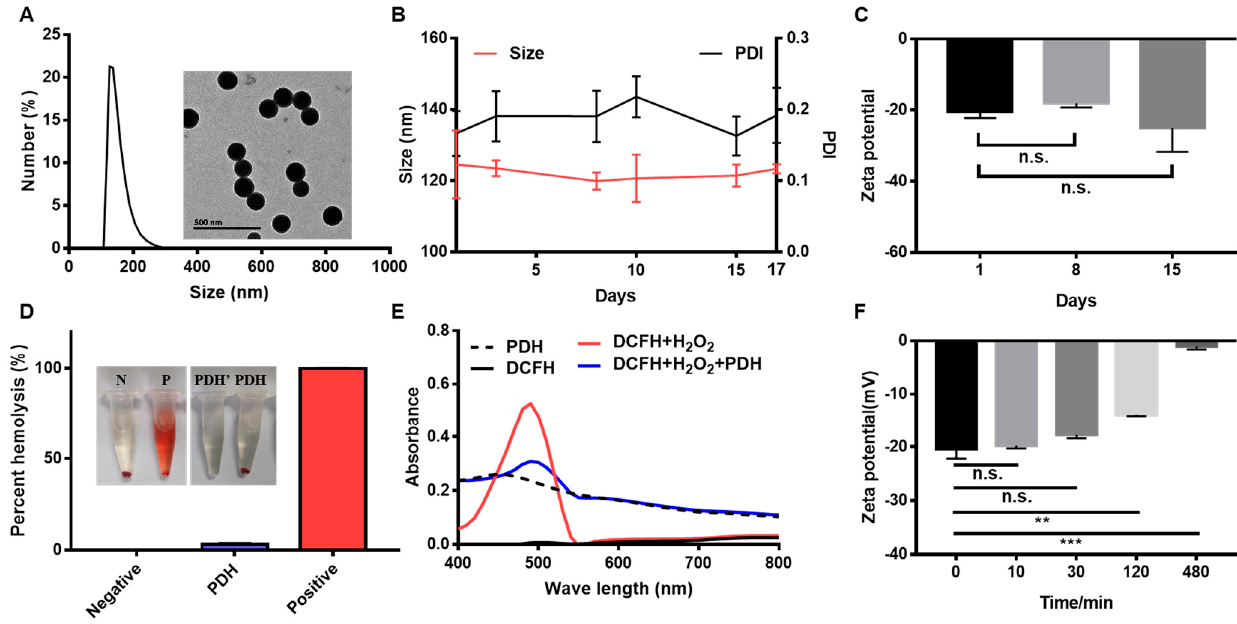
Figure 1. Characterization of PDH nanoparticles. ( A ) The size distribution and TEM images (inserted) of PDH nanoparticles. ( B ) Changes in nanoparticle size and polydispersity index after storage for 1, 3, 8, 10, 15, and 17 days. ( C ) Changes in zeta potential after storage for 1, 8, and 15 days. ( D ) The hemolysis rate and images (inserted) of red blood cells after incubation with different nanoparticles. N: negative control, P: positive control, PDH’: PDH sample mixed with saline, PDH: PDH sample mixed with red blood cells. ( E ) The absorbance of PDH, DCFH, DCFH + H 2 O 2 , and DCFH + H 2 O 2 + PDH under different wavelengths. ( F ) Changes in zeta potential of PDH nanoparticles after incubation with calcium ion-containing solution (calcium chloride aqueous solution). (Results are presented as mean ± SD, n.s. is non-significant, ** p < 0.01, *** p < 0.001, n = 3).